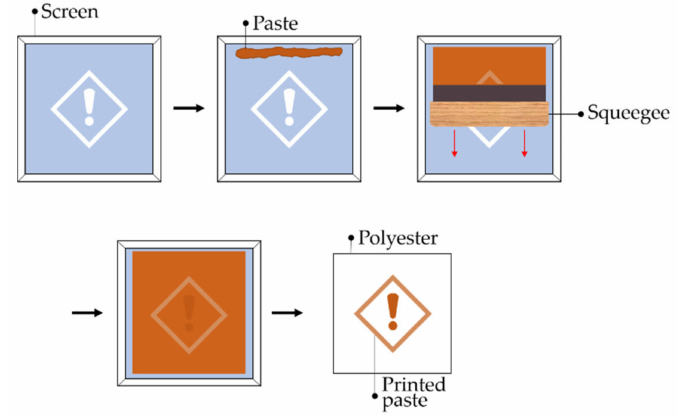
Scheme 1. Schematic diagram of the screen-printing